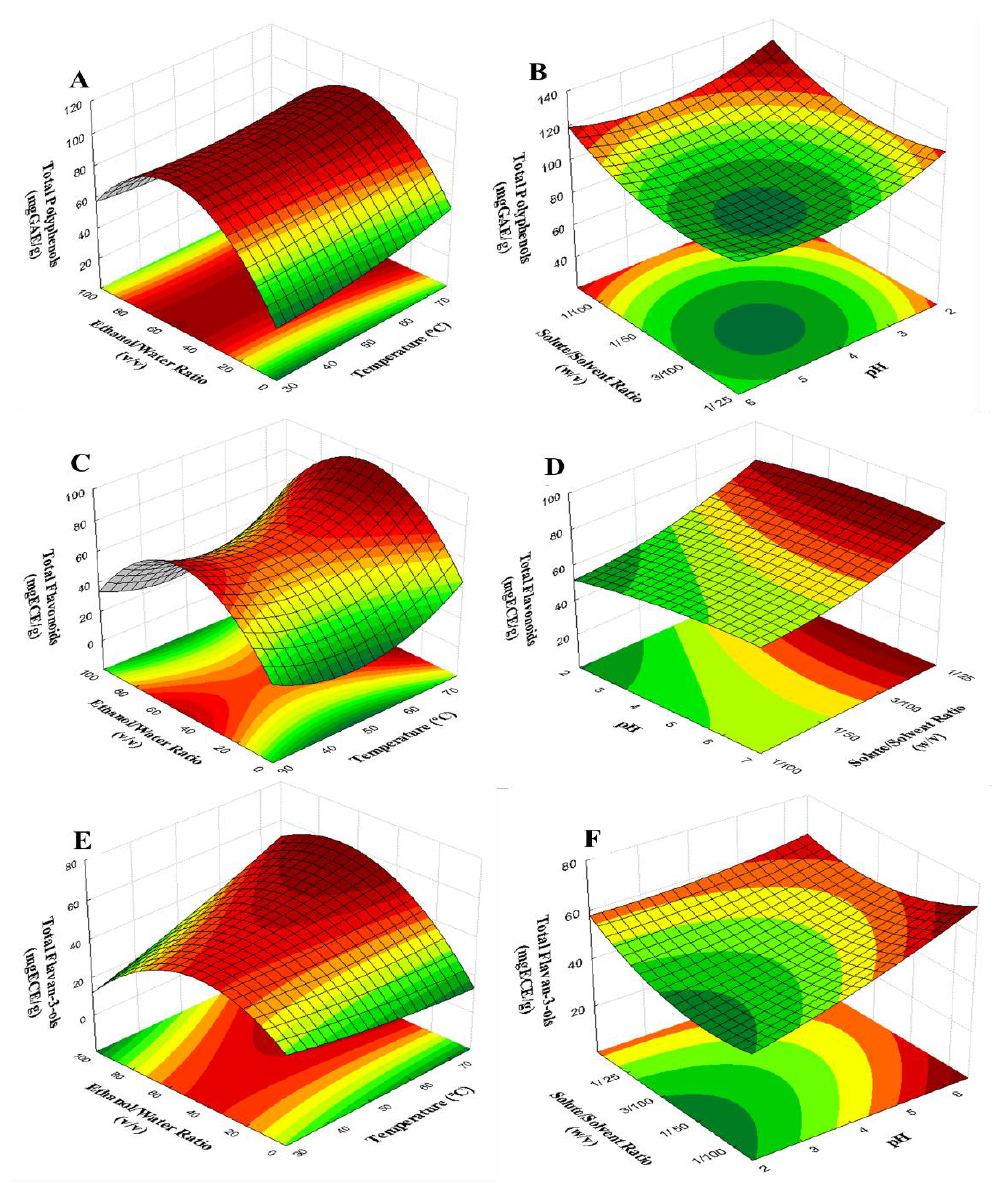
Figure 3. Surface response as function for Temperature vs. Ethanol concentration, and pH vs. solute concentration for the recovery of total polyphenols ( A , B ), total flavonoids ( C , D ) and total flavan-3-ols ( E , F ).